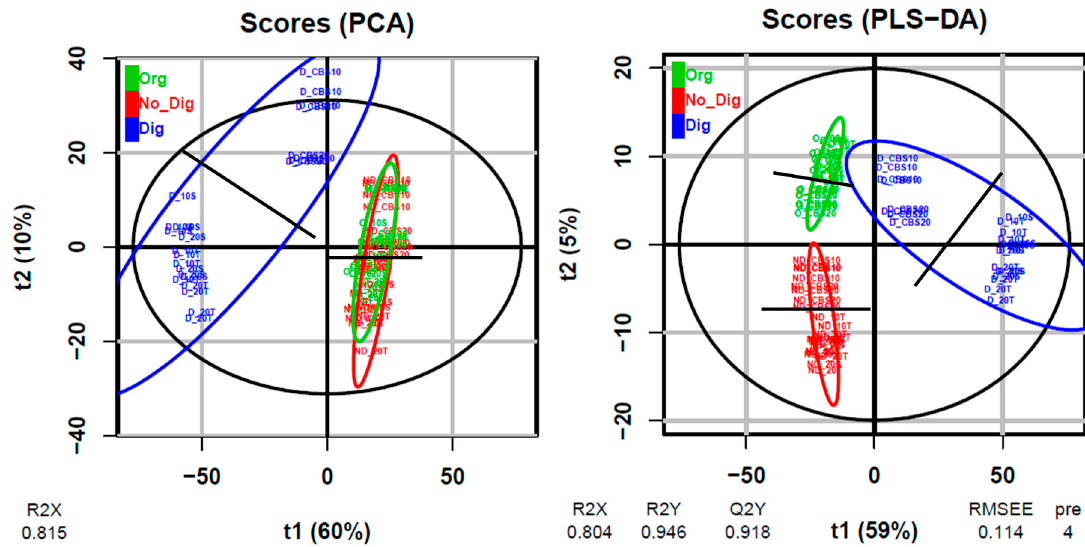
Figure 2. Score plots for the multivariate modeling of variations using PCA (principal component analysis ) or PLS-DA (partial least squares discriminant analysis ) of all samples (biscuits and equivalent quantities of CBS alone without a food matrix) which were subjected to three different types of extraction (Org, No_Dig, and Dig). For each plot, the percentages of total variation explained by components 1 and 2 (t1 and t2, respectively) are indicated in parentheses. Black ellipses include 95% of the multivariate normal distribution for all samples (subgrouped in colored ellipses according to the extraction type).